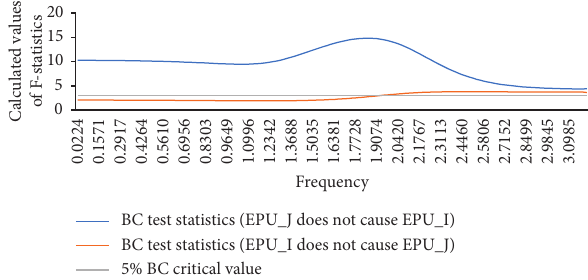
Figure 5: The frequency domain causality between Japan’s and India’s EPU indices. The part of the lines above the critical value- line indicates rejection of the null hypothesis of no Granger